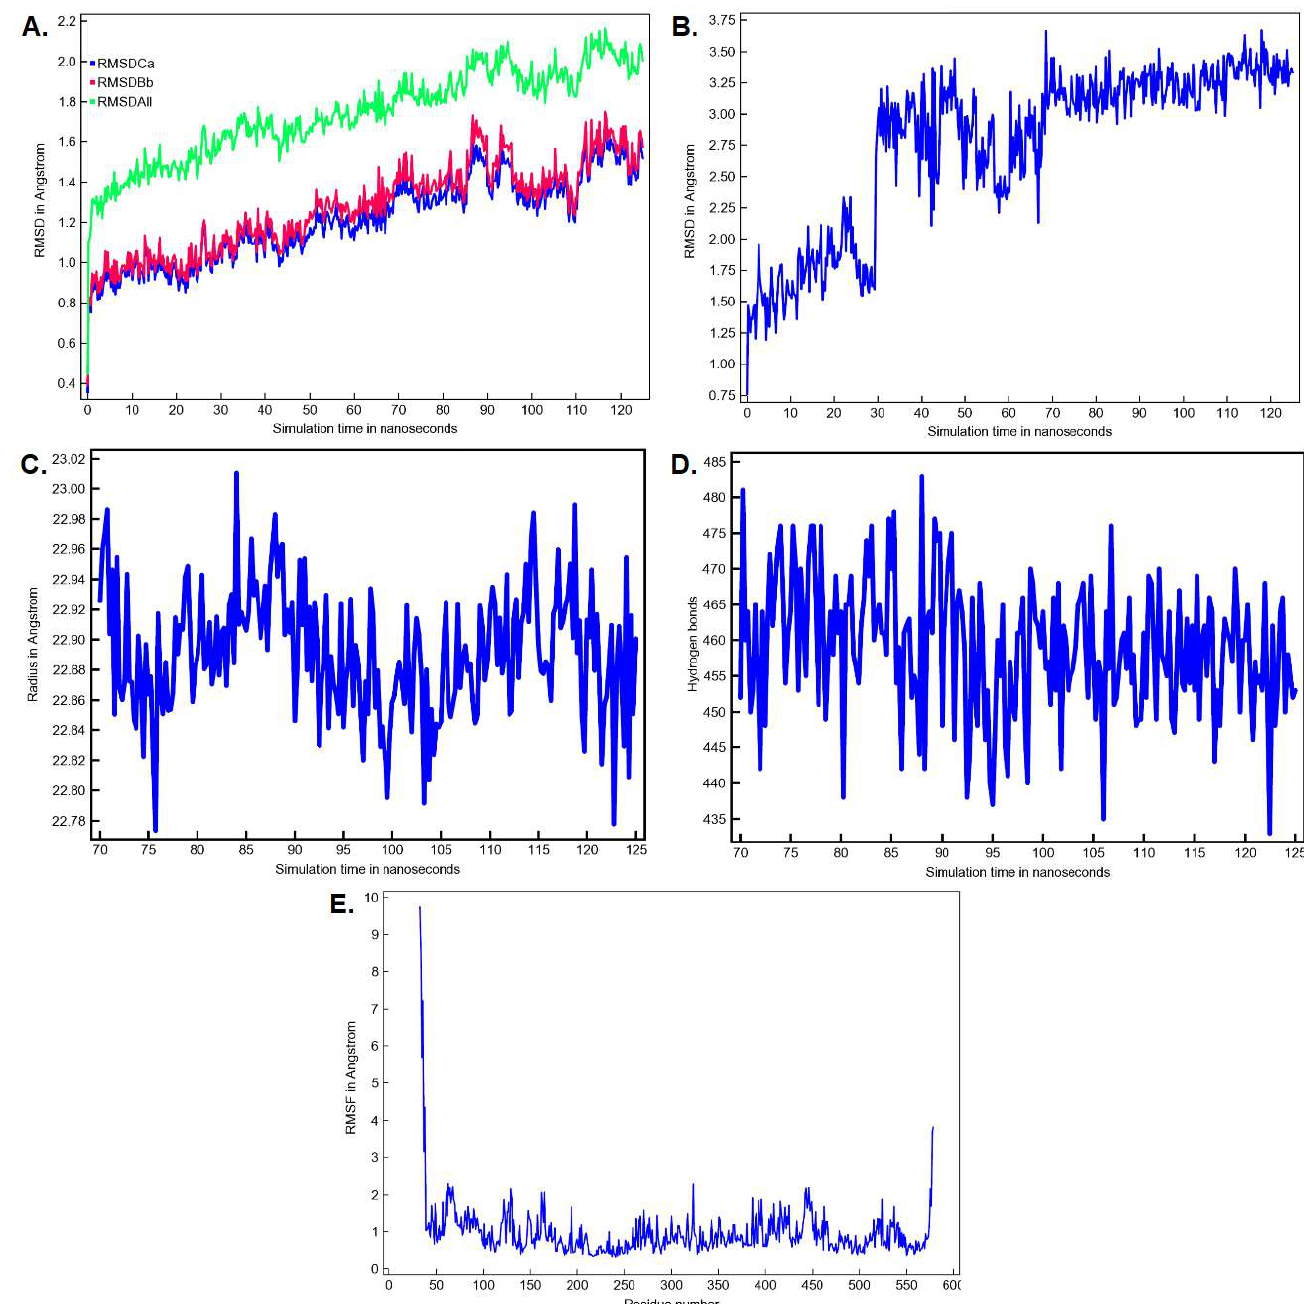
Figure 10. MD simulation parameters for the FAAH-montelukast complex ( A ) The time-dependent RMSD profile of the solute over 125 ns; ( B ) The time-dependent RMSD profile of ligand movement over 125 ns; ( C ) The radius of gyration of the solute over the last 55 ns; ( D ) The number of intramo- lecular hydrogen bonds over the last 55 ns: ( E ) The RMSF per amino acid residue over the last 55 ns. Ca—C-alpha (central carbon atoms); Bb—backbone atoms; All—all heavy atoms.